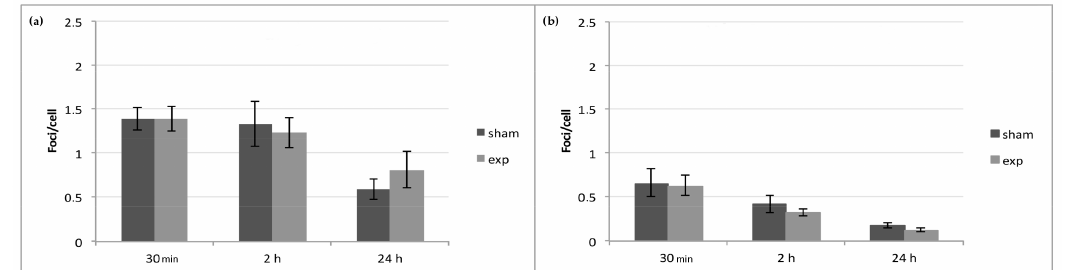
Figure 1. H2AX histone / p53 binding protein 1 ( γ -H2AX / 53BP1) foci analysis on HDF exposed to 2.45 GHz. No significant differences were observed 30 min, 2 h, or 24 h after exposure to 2.45 GHz CW ( a ) and PW ( b ), with respect to sham samples. Results obtained with the cells exposed to CW or PW signals were compared to those obtained with the corresponding sham cells (exposed 30 min vs. sham 30 min; exposed 2 h vs. sham 2 h; exposed 24 h vs. sham 24 h; 2-tailed t -test). Data are representative of four experiments, and bars denote the standard error.